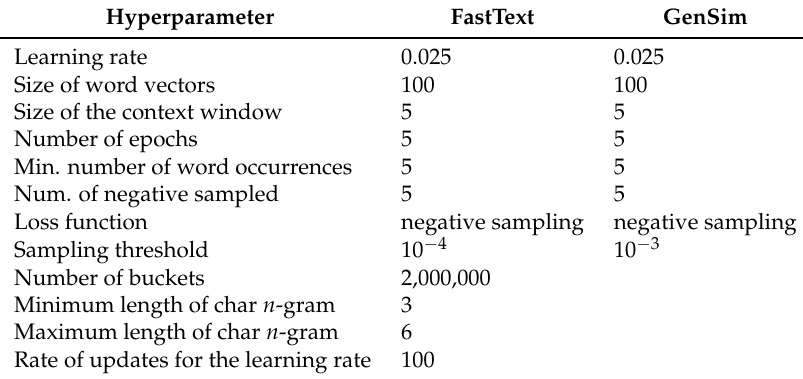
Table 1. Word2Vec hyperparameters using FastText and GenSim. Optimization was performed using random search